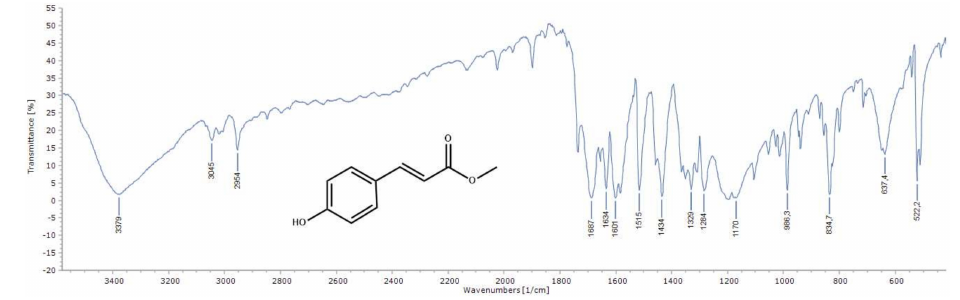
Figure 1. Infrared spectrum (cm − 1 ) of methyl p -coumarate ( 1 ).